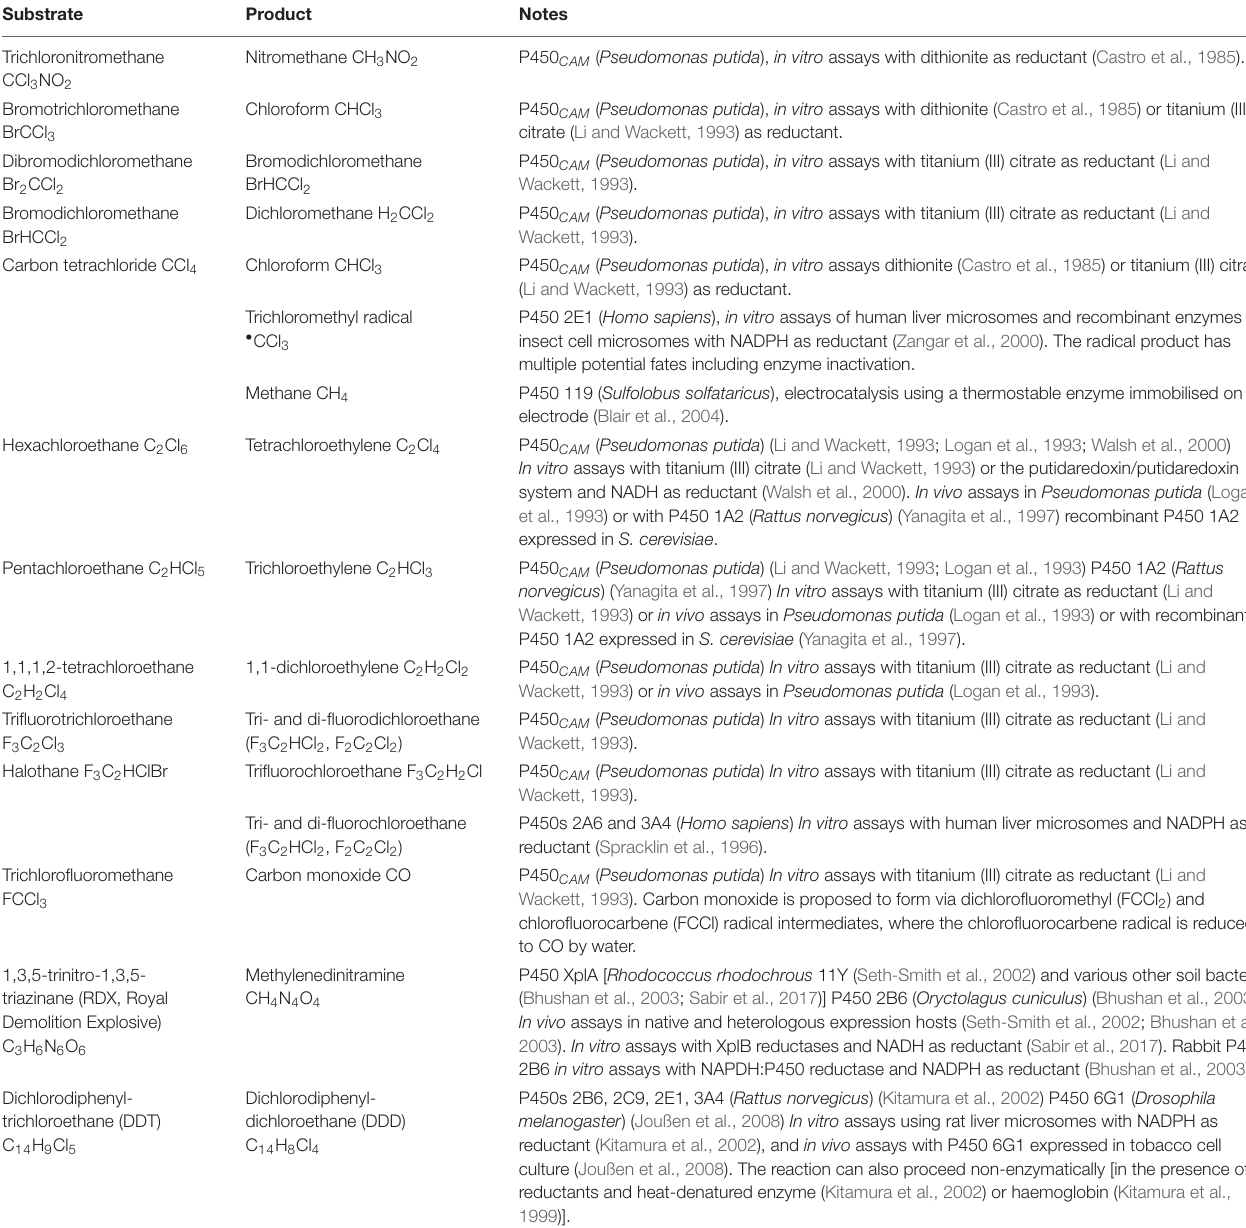
TABLE 1 | Summary of known P450-mediated reductive dehalogenation and denitration